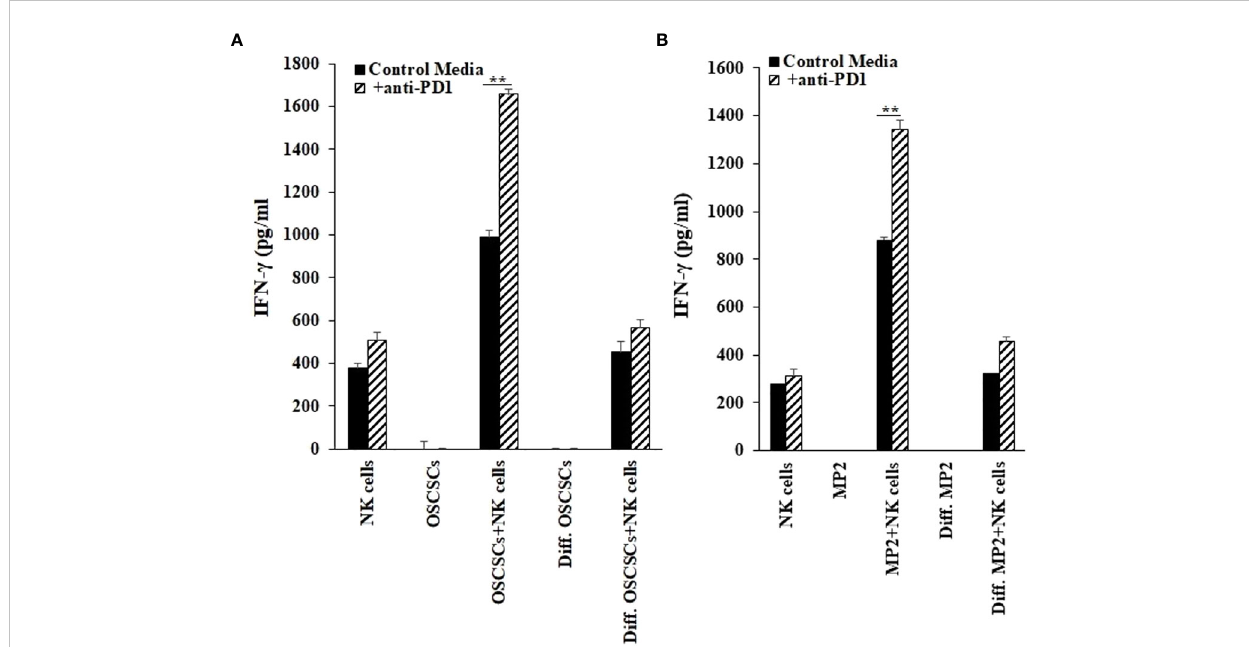
FIGURE 6 Increased IFN- g secretion by NK cells in the presence of cancer stem cells and anti-PD1. OSCSCs were differentiated using IL-2 (1000 U/ml) and anti-CD16 mAbs (3µg/mL) treated NK cell supernatants as described in the Materials and Methods section. NK cells of healthy individuals were treated with IL-2 (1000 U/ml) for 18-20 hours before they were co-cultured with tumor cells (NK: tumors; 1:1), and treated with anti-PD1 (500 ng/ ml) antibody. On day 3 of co-culture, the supernatants were harvested and the secretion of IFN- g was determined using single ELISAs (A) . MP2 cells were treated with IL-2 (1000 U/ml) and anti-CD16 mAbs (3µg/mL) treated NK cell supernatants to induce differentiation as described in the Materials and Methods section. NK cells of healthy individuals were treated with IL-2 (1000 U/ml) for 18-20 hours before they were added to tumor cells (NK: tumors; 1:1), and were treated with anti-PD1 (500 ng/ml) antibody. On day 3 of co-culture, the supernatants were harvested and the secretion of IFN- g was determined using single ELISA (B) . **( p value